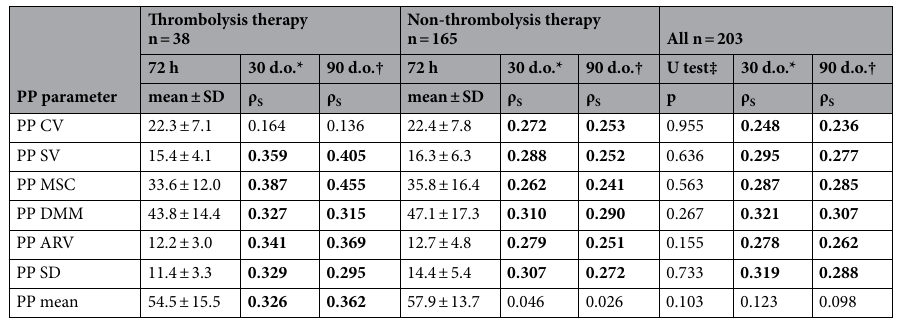
Table 2. Association between PPV parameters measured during 72 h after admission and outcome determined by mRS at 30- and 90-days post-stroke period (in bold if p < 0.05). *30 d.o. = 30 days outcome; † 90 d.o. = 90 days outcome; ‡U—the test compares PP parameters between the groups with and without thrombolysis. ARV: average real variability; CV: coefficient of variation; DMM: difference maximum- minimum; MSC: maximal successive change; PP: pulse pressure; ρ S : Spearman ρ; SD: standard deviation; SV: successive variation.